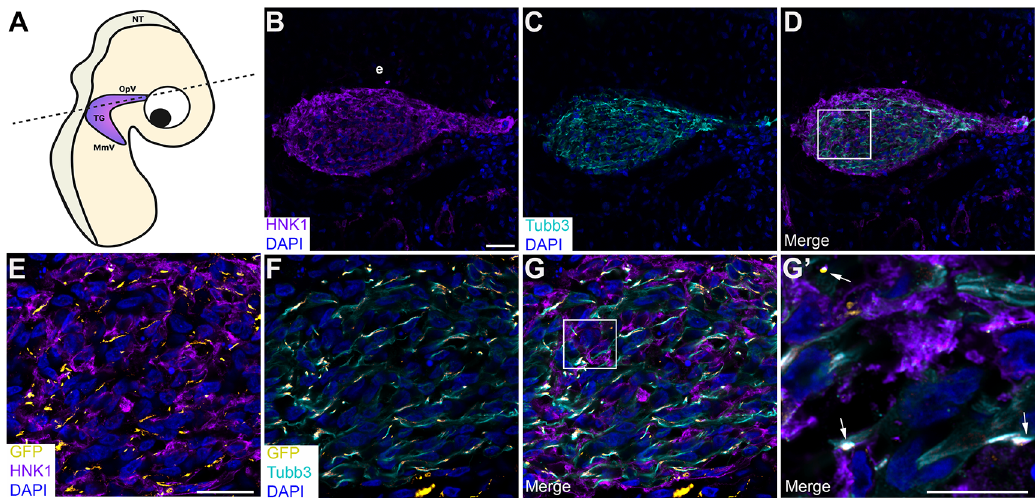
Figure 8. Cadherin-7 GFP11 and N-cadherin GFP1-10 form heterophilic interactions in trans in the trigeminal ganglion. (A) Cartoon diagram of a chick embryo showing the forming trigeminal ganglion, with the dotted line indicating the axial level at which images were captured. Diagram created with BioRender.com. Sequential electro- porations in the chick embryo were conducted as follows: Premigratory neural crest cells were first electroporated with Cad7 GFP11 followed by electroporation of trigeminal placode cells with N-cad GFP1-10. Section immunohisto- chemistryforHNK1(purple,marksneuralcrestcells;B,D,E,G,G ’ )andTubb3(cyan,marksneuronswhichareplacode cell-derived at this stage; C, D, F, G, G ’ ) was then performed. GFP signal (yellow, arrows, E-G ’ ) was captured in the appropriate channel(488). (B-D) Representative sections that show themorphology of thetrigeminalganglion at this stage of development. (E-G) Higher magnification images of the boxed region in (D). (G ’ ) Higher magnification image of the boxed region in (G), with GFP identified by arrows. DAPI (blue), cell nuclei. N=13 embryos. Scale bar in (B) is 100 μ m and applies to (C-D); scale bar in (E) is 100 μ m and applies to (F-G); and scale bar in (G ’ ) is 50 μ m. NT, neural tube; MmV, maxillomandibular lobe; OpV, ophthalmic lobe; TG, trigeminal ganglion; e, ectoderm; N-cad, neural cadherin; Cad7, Cadherin-7; GFP, green fluorescent protein; HNK-1, human natural killer-1; Tubb3, Tubulin beta-3 chain.